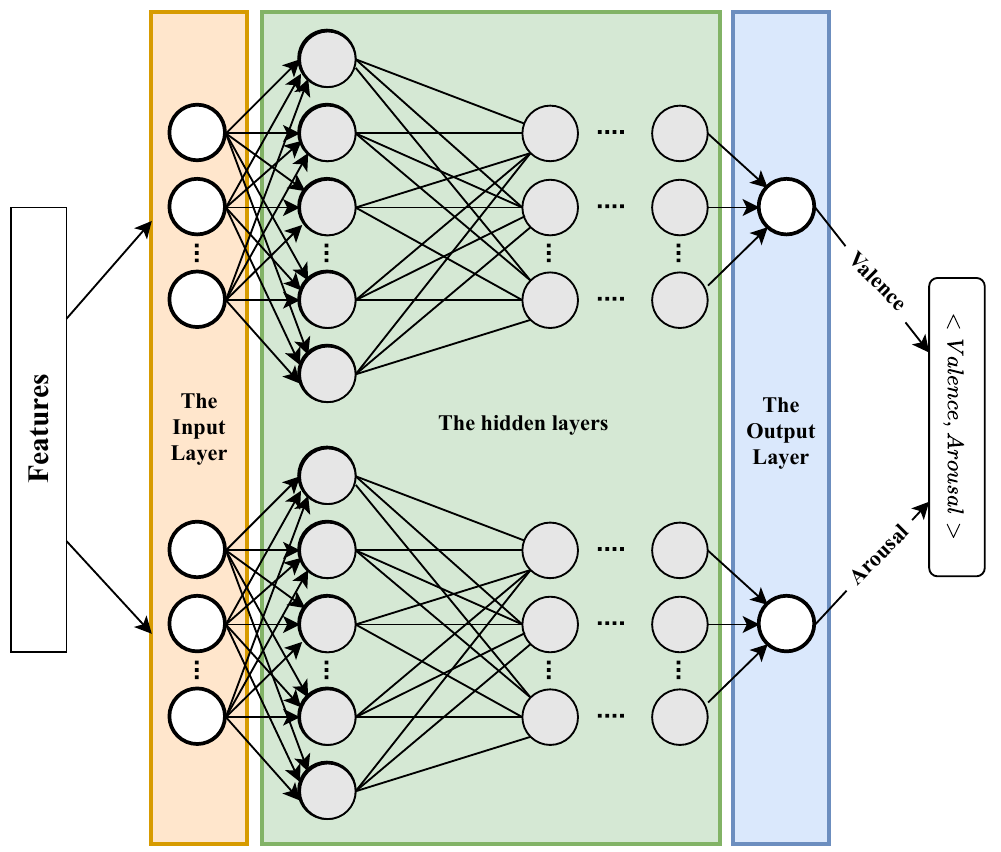
Figure 3. The general architecture of